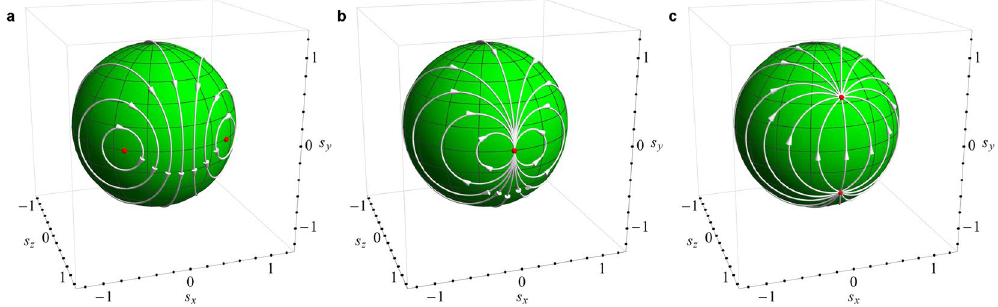
Figure 2. Transition between elliptic ( a ) and loxodromic ( c ) Möbius transformations by increasing ε past the critical value 1, at which one obtains the parabolic transformation ( b ). In classical spin dynamics this transition corresponds to PT